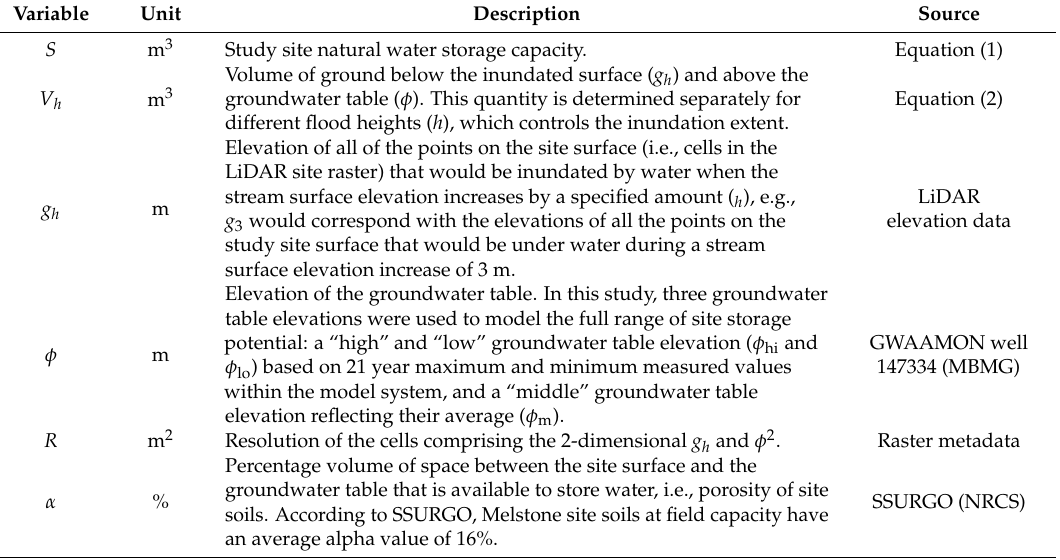
Table 1. Description of site storage quantification equation